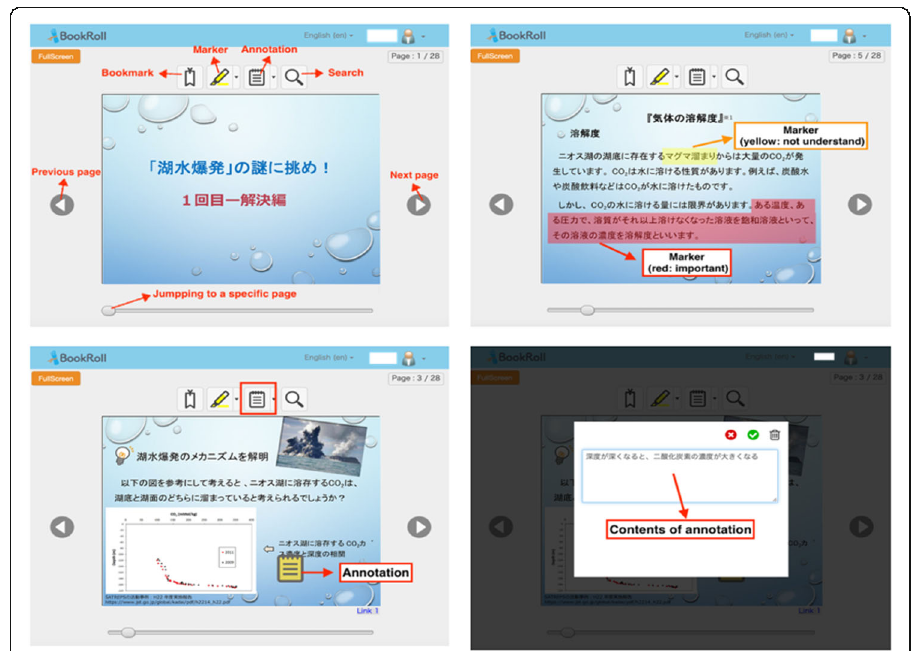
Fig. 1 The BookRoll system interface of the Limnic Eruption lesson